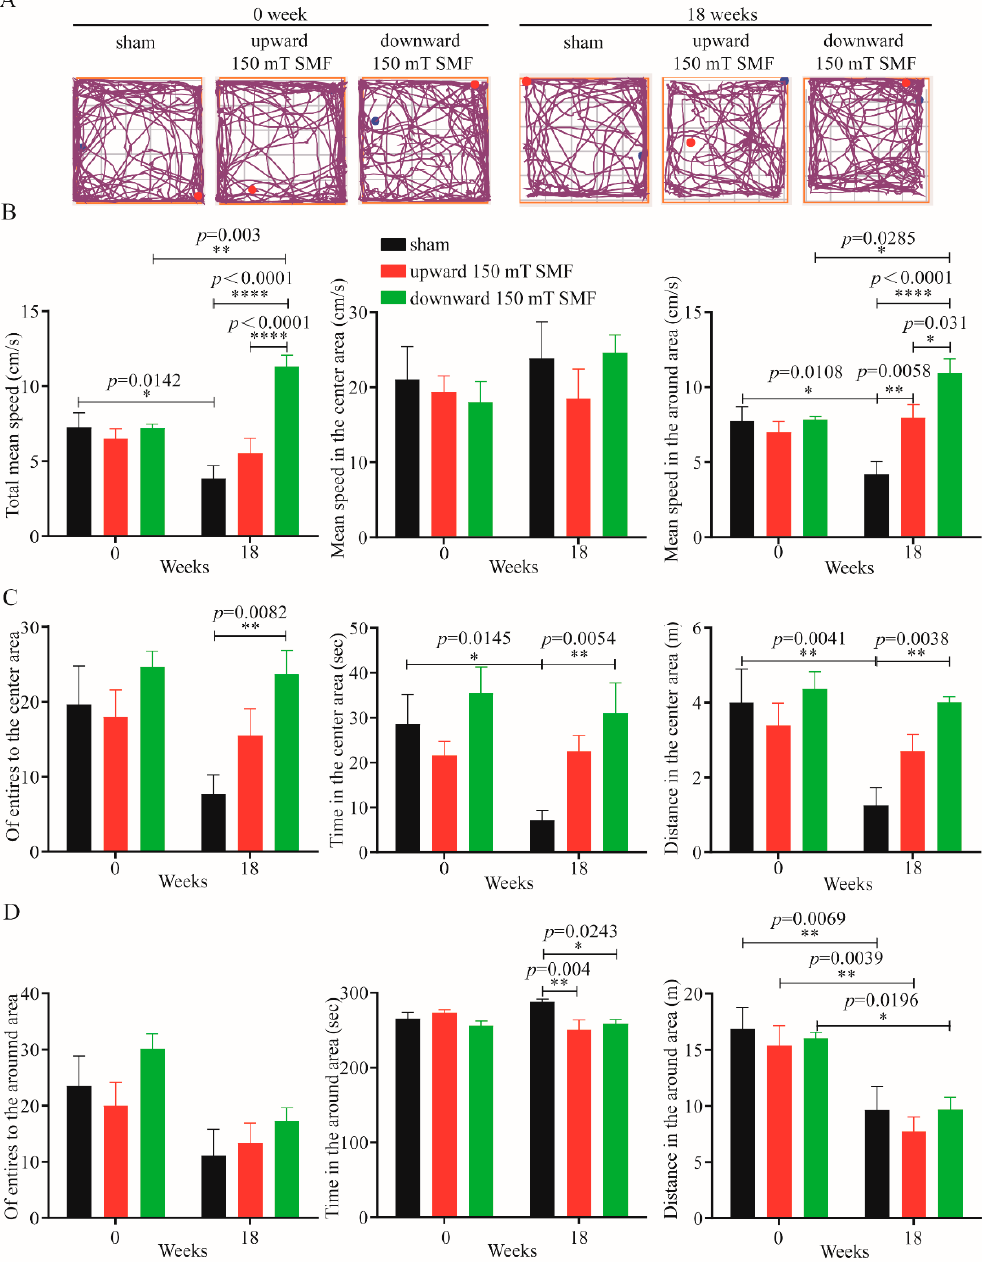
Figure 4. Open field tests showed that long-term 150 mT SMFs exposure could improve athletic ability and reduce anxiety-like behavior. ( A ) Movement trajectories of mice in open field experiments; the start and end points of the movement are indicated by the blue and red dots, respectively. ( B ) The mean movement speed of mice in sham and 150 mT SMF groups, including the mean speed in the central, peripheral area and the mean speed during the test. ( C ) Motion parameters of the mice in the central area, including the entries, time and distance. ( D ) Motion parameters of the mice in the around area, including the entries, time and distance. All the data were represented as the mean ± SEM. “*” means p < 0.05, “**” means p < 0.01, “****” means p < 0.0001.